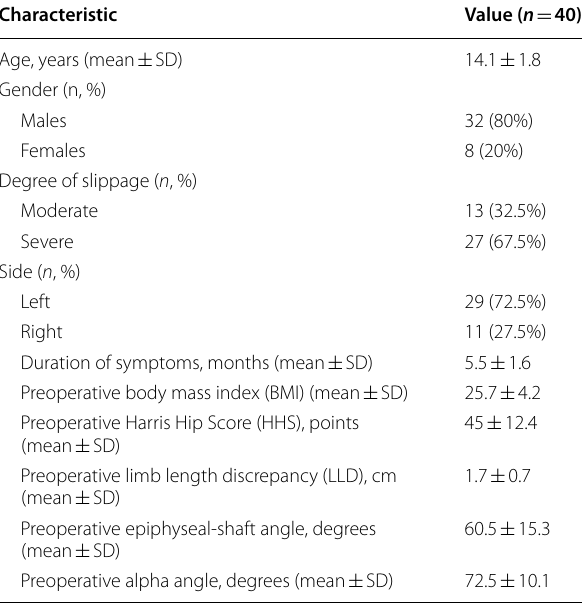
Table 1 Demographics and baseline characteristics of the included patients